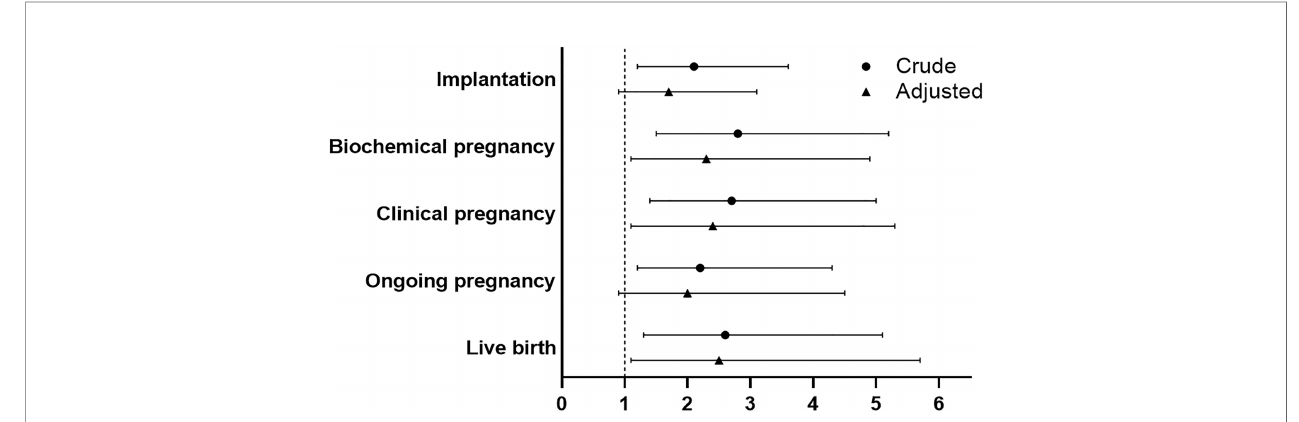
FIGURE 2 | Comparison of reproductive outcomes between PPOS and ultra-long GnRHa protocol. PPOS, progestin-primed ovarian stimulation; GnRHa, gonadotrophin-releasing hormone agonist; OR, odds ratio; CI, con fi dence interval. The reference was the PPOS group, adjusted for maternal age, maternal BMI, total antral follicle count, adenomyosis, number of transferred embryos (1 versus 2), stage of embryo, fertilization